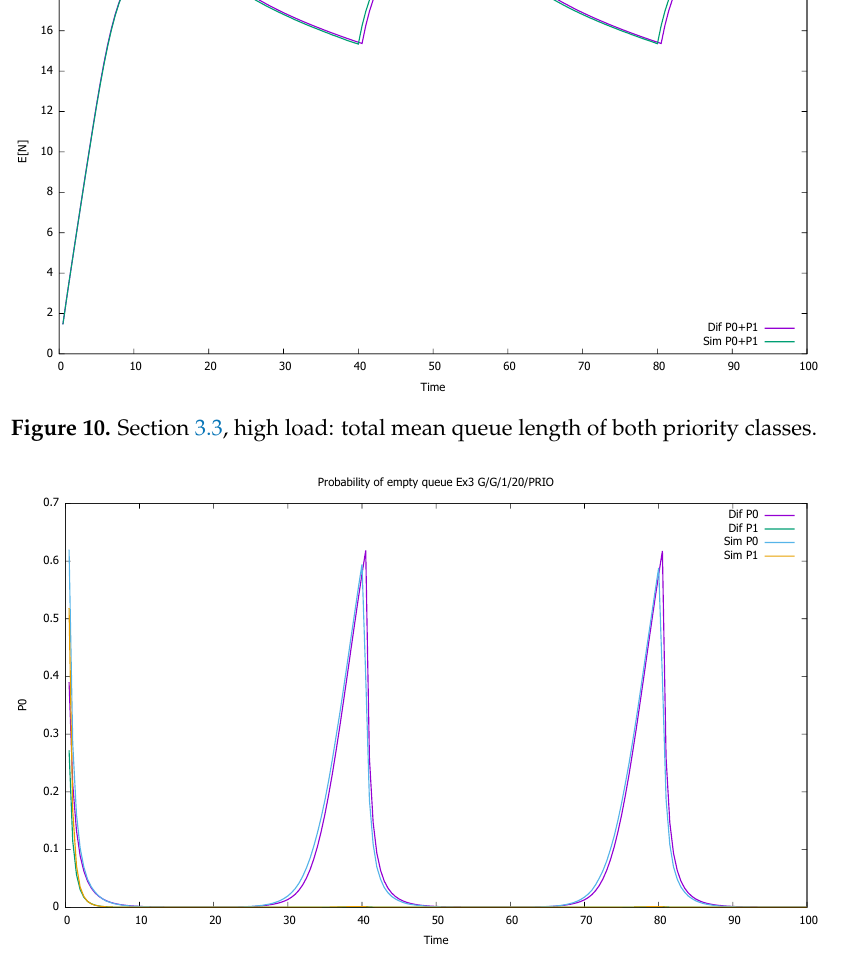
Figure 11. Section 3.3, high load: probabilities of empty queues for priority (P0) and non-priority (P1) classes.